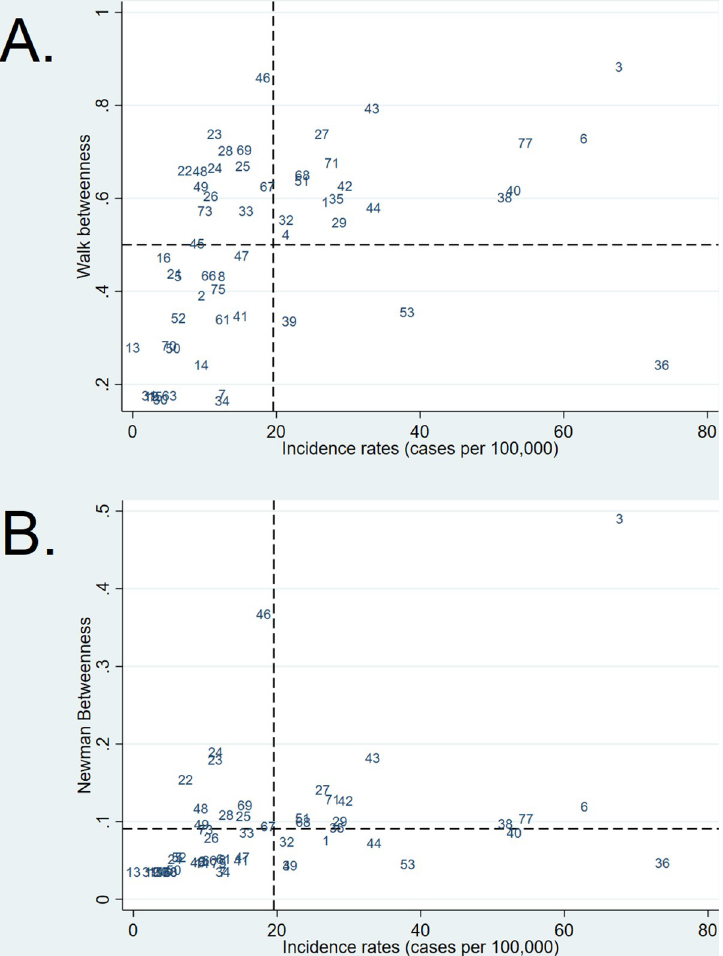
Fig 4. Hidden bridging communities in Chicago. Using the aggregated contract tracing data from STD specialty clinics in Chicago, we plot incidence rates of syphilis during the period 2001 − 2002 (on the x-axis) against scores of walk-betweenness and Newman betweenness (on the y-axis) to identify the hidden bridging communities (upper-left areas) that are priori given less attention.